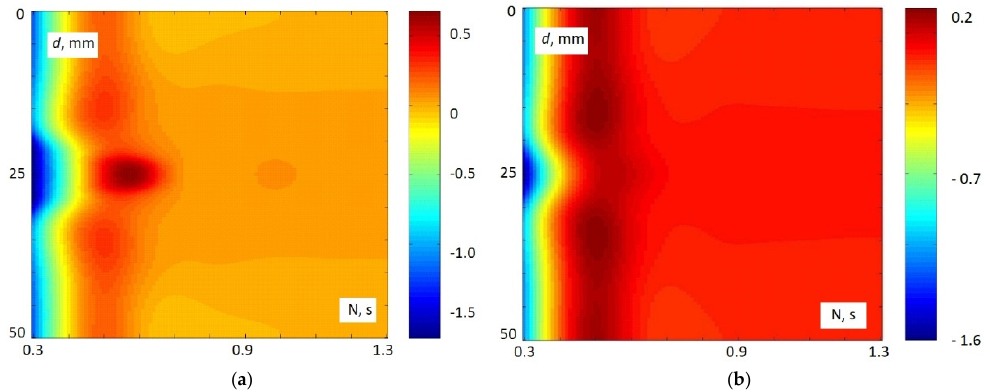
Figure 8. WT phase at defect depth: ( a ) 0.5 mm and ( b ) 2.5 mm. Reprinted and adapted with permission from Ref. [53]. Copyright 1999, AITA.